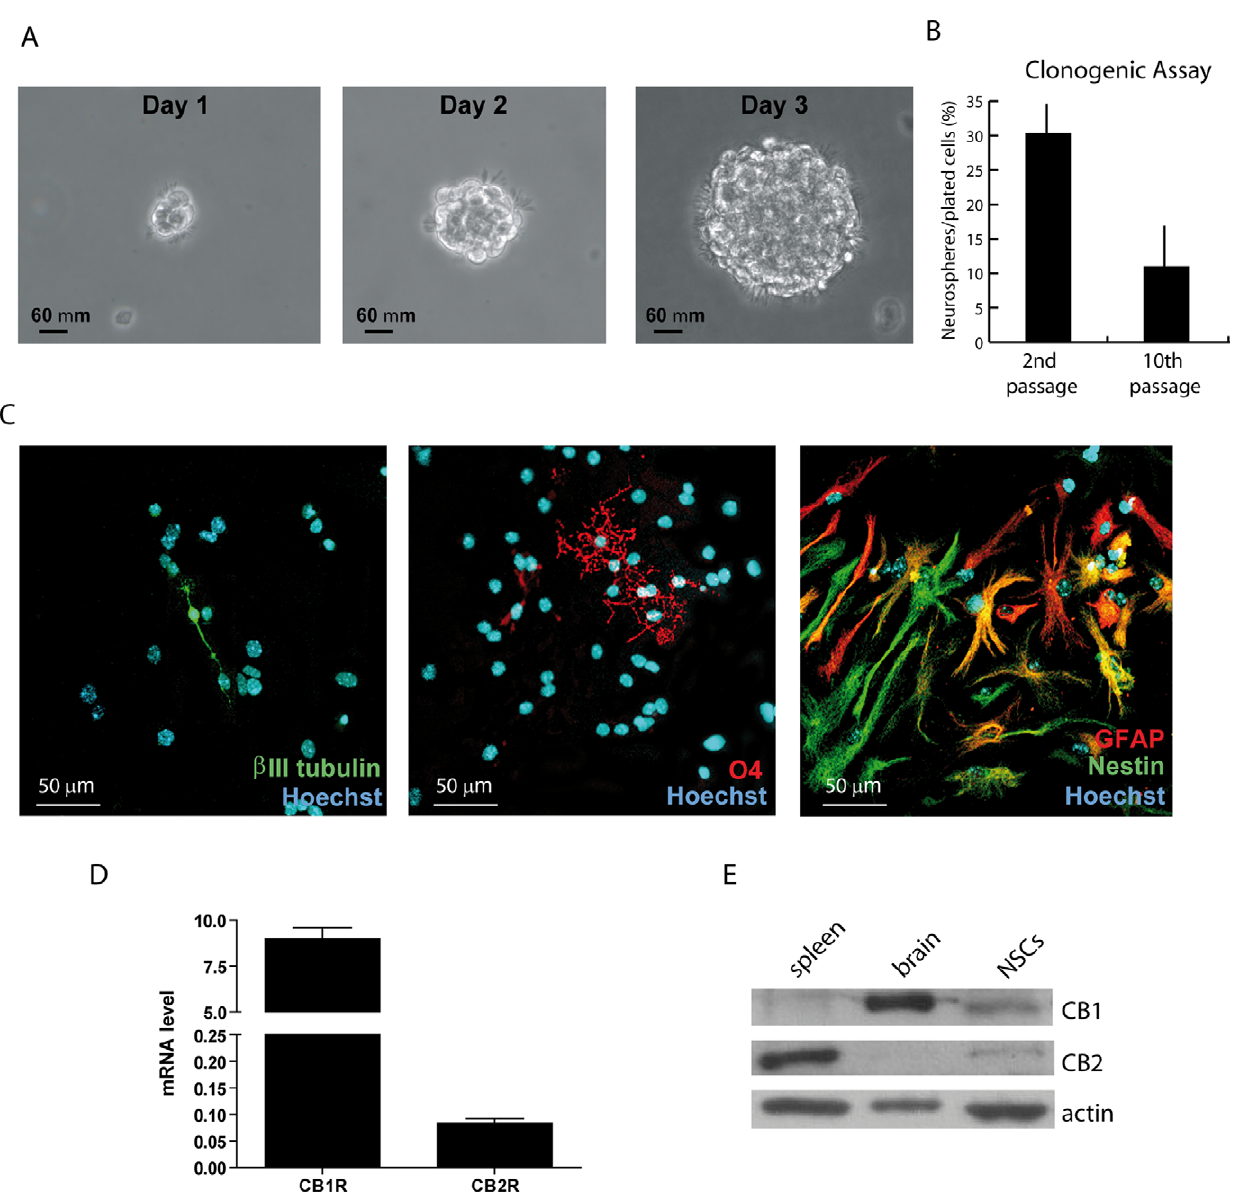
Figure 1. Neural stem cells (NSCs) express high levels of CB 1 receptor. ( A ) Bright field photographs of murine NSCs forming neurospheres from single cell suspensions after one, two and three days in EGF and b-FGF. ( B ) Bar graph representing the clonogenic capacity of NSCs at the 2 nd and 10 th passage (n=6). ( C ) Immunofluorescence analysis showing NSCs cultured in differentiating conditions (devoid of EGF and b-FGF, and supplemented with 1% FCS) and stained with the neuronal marker b -III tubulin (left panel), the oligodendrocyte marker O4 (middle panel), and co- stained with the astrocyte marker GFAP (red in the right panel) and with the neural progenitor marker Nestin (green in the right panel). Cells positive for both GFAP and Nestin were considered neural progenitors that are differentiating toward astrocytes ( i.e. immature astrocytes). ( D ) qPCR analysis showing the levels of CB 1 and CB 2 receptor transcripts, normalized for levels of the housekeeping gene b - actin . ( E ) Western blot analysis showing the expression levels of CB 1 and CB 2 receptor proteins in extracts obtained from NSCs, brain and